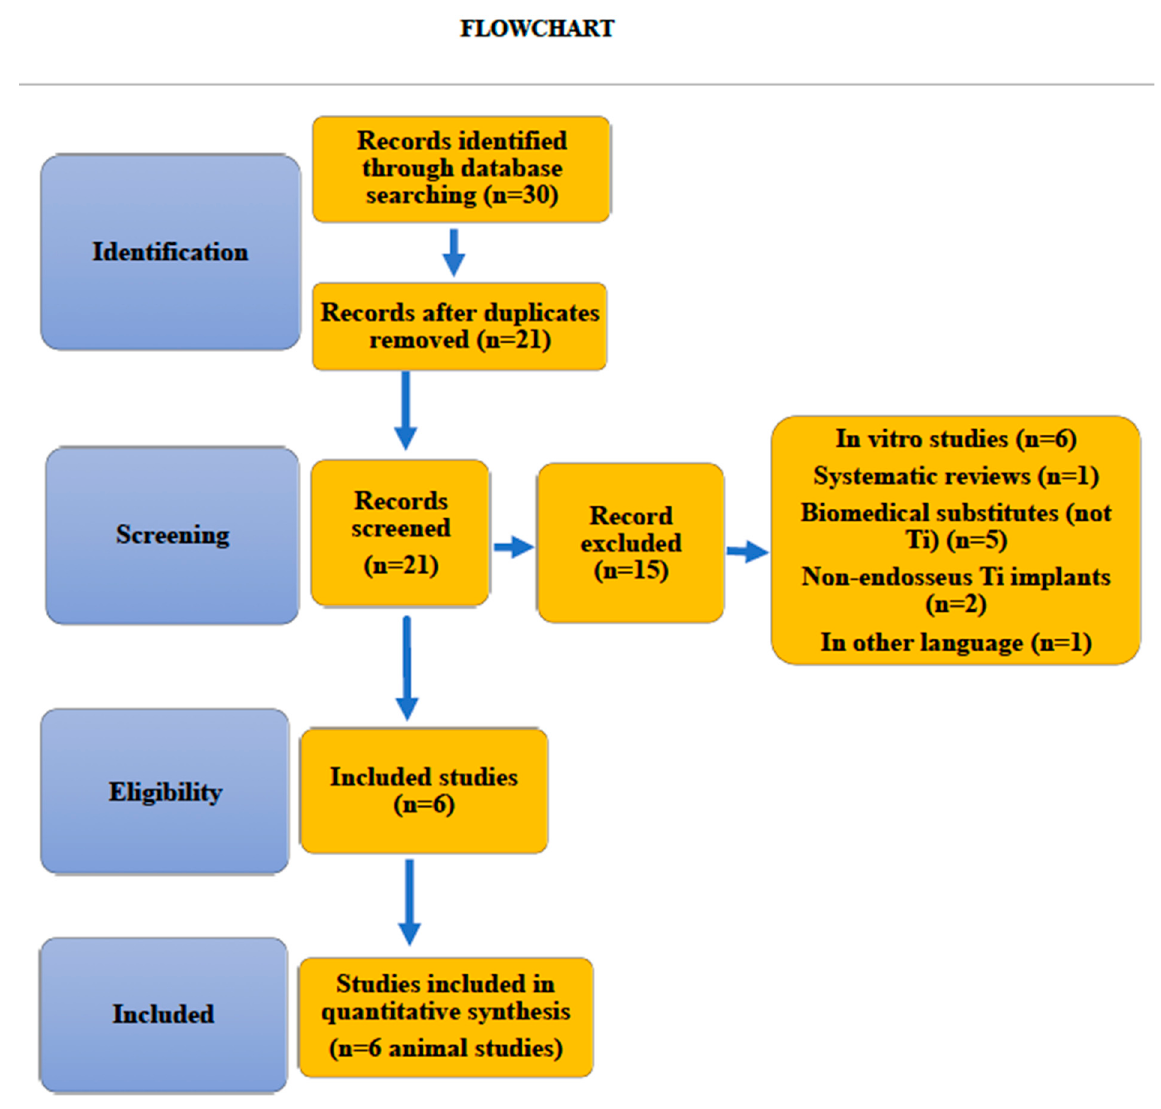
Figure 2. Figure 2. Flowchart.